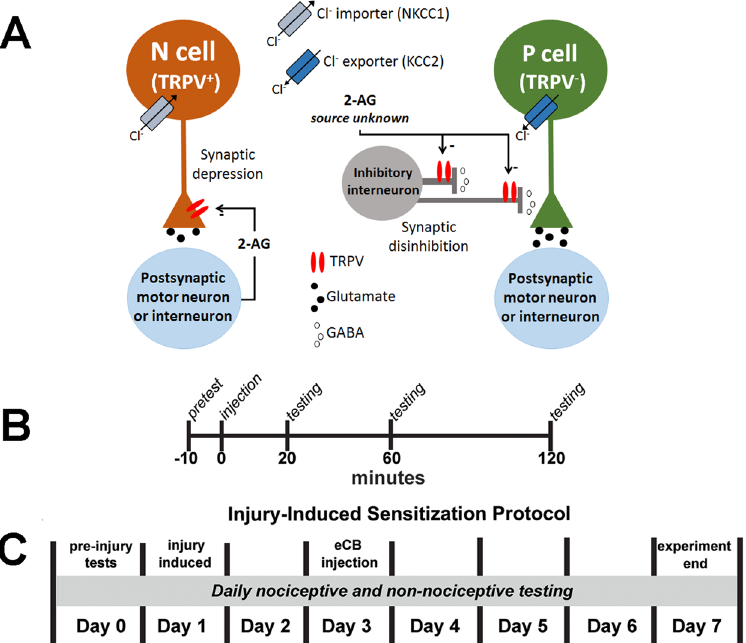
Figure 1. Endocannabinoid-mediated synaptic plasticity in Hirudo synapses and experimental protocols. ( A ) Endocannabinoids directly depress the nociceptive (N) synapse via a presynaptic TRPV-like receptor that reduces neurotransmitter release 31, 34, 35 . Endocannabinoids potentiate the non-nociceptive synapse (P) via an indirect mechanism in which endocannabinoids depress inhibitory input from an unknown GABAergic interneuron (this is also TRPV-mediated). In N cells the Cl − gradient is dominated by the Cl − importer (NKCC1) while the P cell gradient is dominated by the Cl − exporter (KCC1) 36 . As a result of an elevated intracellular Cl − concentration, N cells are depolarized by GABA and consequently “protected” from disinhibition. ( B ) For tests of endocannabinoid effects in uninjured animals, Hirudo were given a pre-test to assess initial responsiveness to non-nociceptive and nociceptive stimuli 10 minutes prior to injection of either anandamide (100 μ M) or 2-AG (75 μ M), with or without 25 μ M SB366791, subsequent tests of nociceptive and non-nociceptive responses were given 20, 60, and 120 mins post-injection. ( C ) For tests of endocannabinoid effects in animals that had undergone injury-induced sensitization, Hirudo responses to non-nociceptive and nociceptive stimuli were first assessed on day 0. On day 1, animals received a crush injury and responses to non- nociceptive and nociceptive stimuli were tested daily. On day 3, some animals received injections of 2-AG or